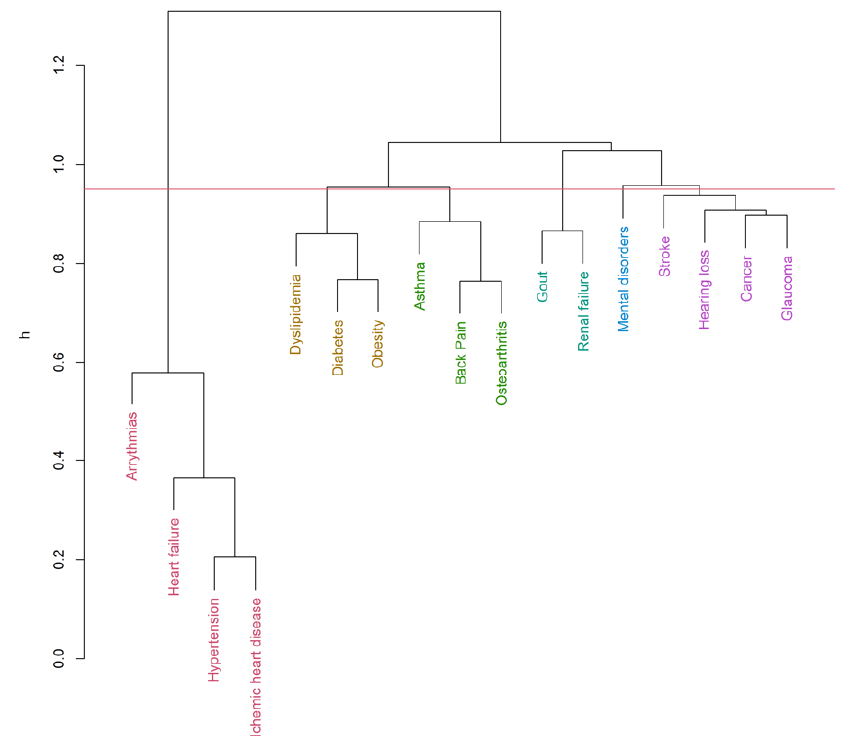
Figure 1. Clusters of comorbidities (COPD group—male, Ward’s method, h = 0.95, average Silhouette width = 0.11, Dunn index = 0.77).